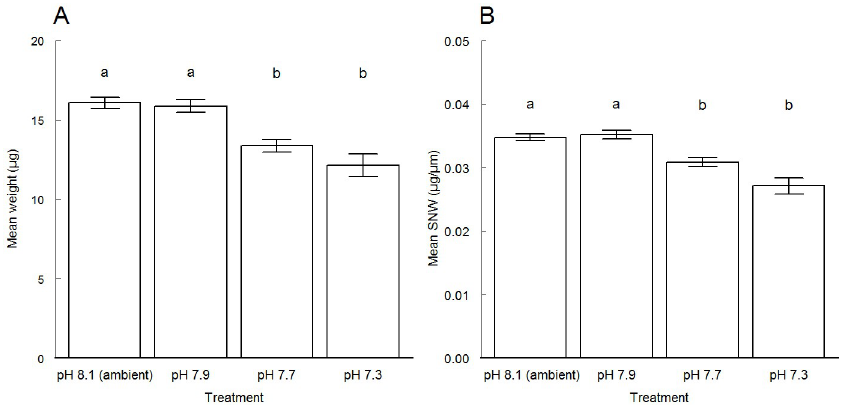
Fig 3. Mean values ( ± standard error) of (A) weight and (B) size-normalized test weight (SNW) for Elphidium williamsoni cultured at different pH conditions. Treatments with significant differences are indicated by different letters (i.e. a and b) above bars at p < 0.05, according to the